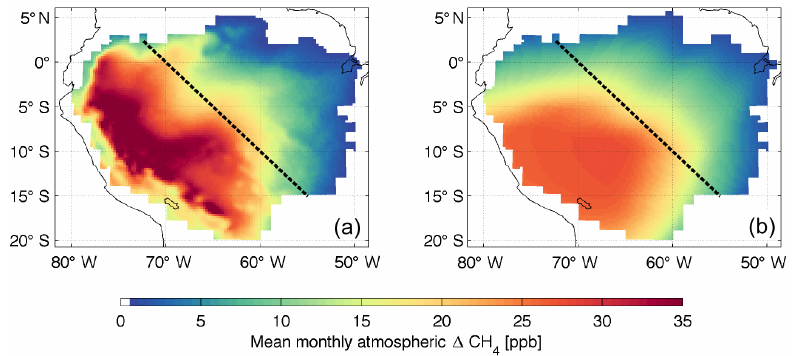
Figure D1. March 2007 simulations of atmospheric CH 4 concentration enhancements – based on 12mgm − 2 day − 1 fluxes throughout the Amazon basin – derived using the WRF atmospheric transport model (a) and the LPDM influence function approach (b) . The dashed line denotes our delineation of “northeast Amazon basin” and “southwest Amazon basin” regions (see Appendix